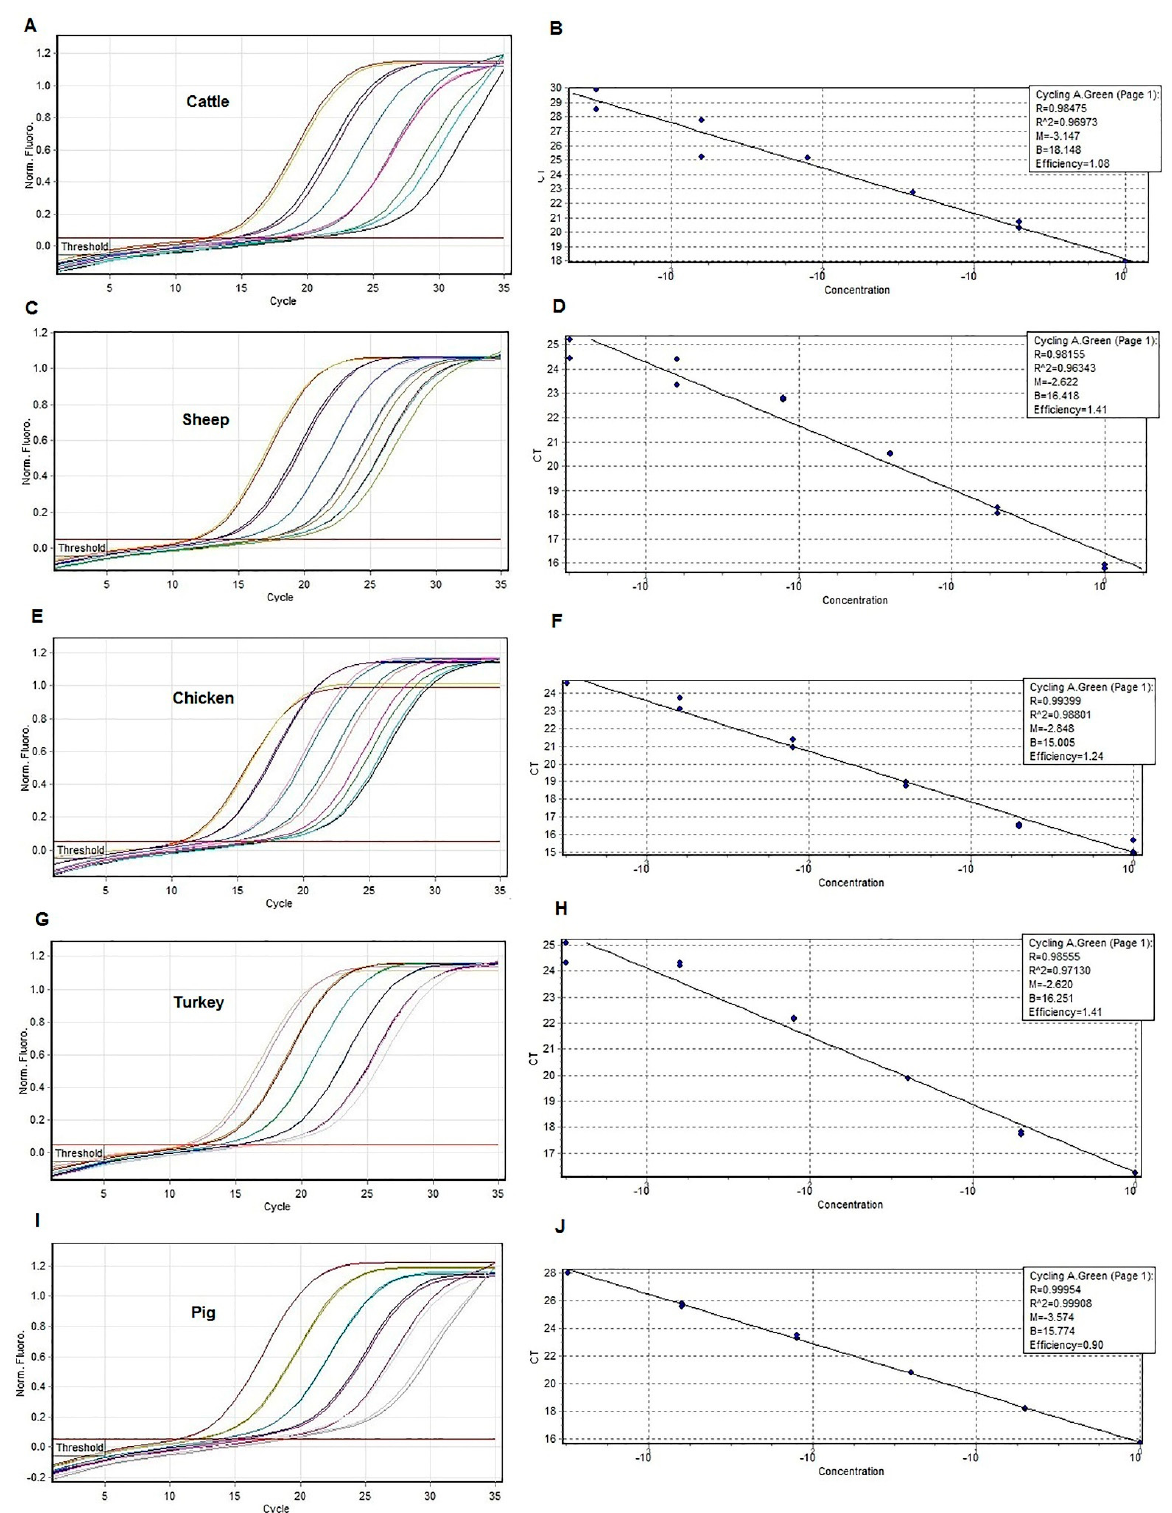
Figure 3. Amplification of serial concentrations of meat DNAs obtained from different species: ( A ) cattle, ( C )B sheep, ( E ) chicken, ( G ) turkey and ( I ) pig. ( B , D , F , H , J ): Six-point calibration curves of meat DNA including 100, 20, 4, 0.8, 0.16, and 0.032% concentrations were evaluated, and the related parameters, such as correlation slope (M), correlation coefficient (R 2 ) and PCR efficiency (E), for each meat’s DNA were calculated as follows: M = − 3.1, R 2 = 0.99 and E >